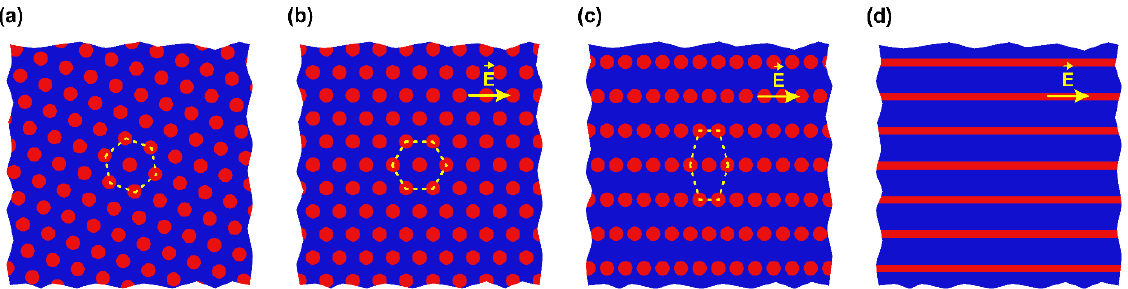
Figure 8. Schematic (top view) of the phase transformation in a strongly separated PS-P4VP film: ( a ) hexagonally packed standing cylinders; ( b ) field-oriented hexagonally packed cylinders; ( c ) lined up cylinders; ( d ) standing lamellas formed upon cylinder merging.